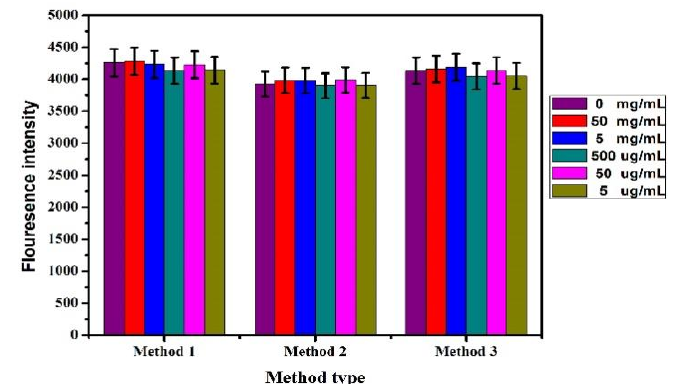
Figure 11. Detection of tea samples treated by different methods.